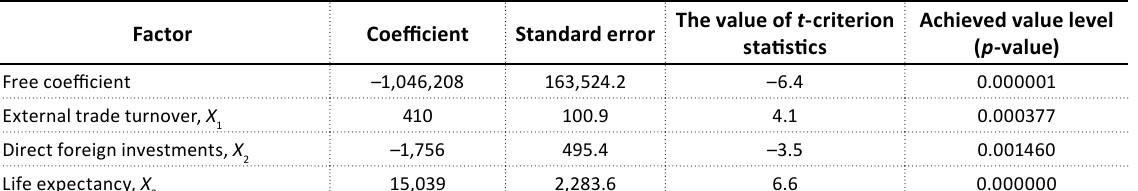
Table 1. The modeling